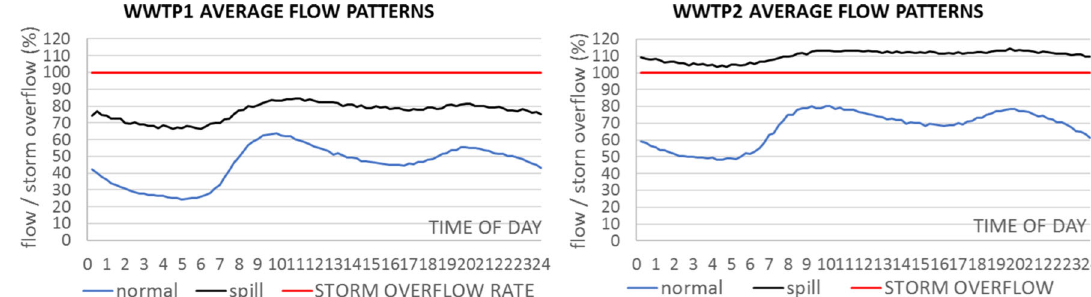
Fig. 2 Average daily fl ow patterns. a WWTP1: black curve for ‘ spill ’ days ( n = 97) and blue curve for ‘ normal ’ days ( n = 349); b WWTP2: black curve for ‘ spill ’ days ( n = 117) and blue curve for ‘ normal ’ days ( n =